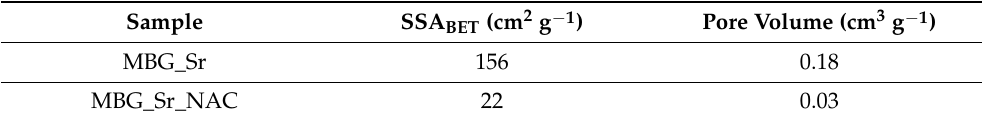
Table 3. SSA and pore volume of MBG_Sr_NAC compared to the MBG_Sr.